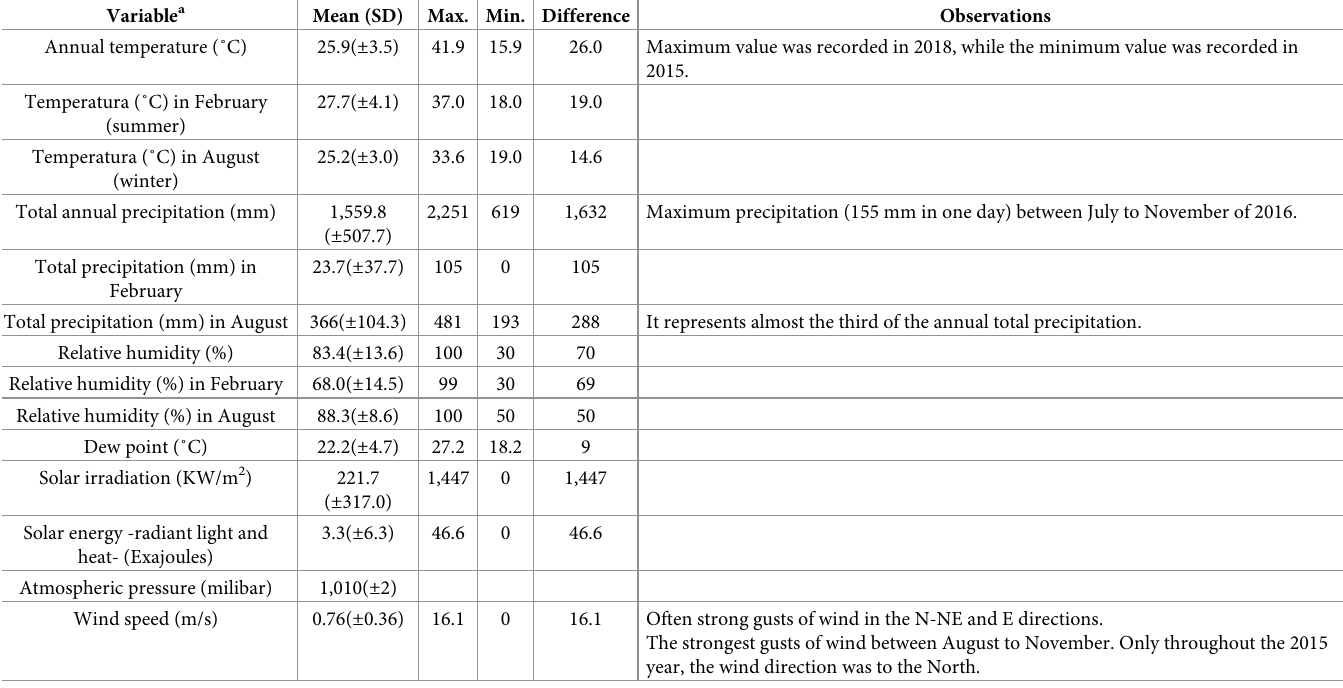
Table 7. Multiannual mean of climatic variables recorded for seven years (2012–2019) in the Matepantano farm (local scale). Variable a Mean (SD) Max. Min. Difference